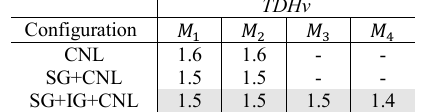
Table IX. Values of THDv (%) in 𝑀 1 ,𝑀 2 ,𝑀 3 𝑒 𝑀 4 with 𝑁 𝐿 .